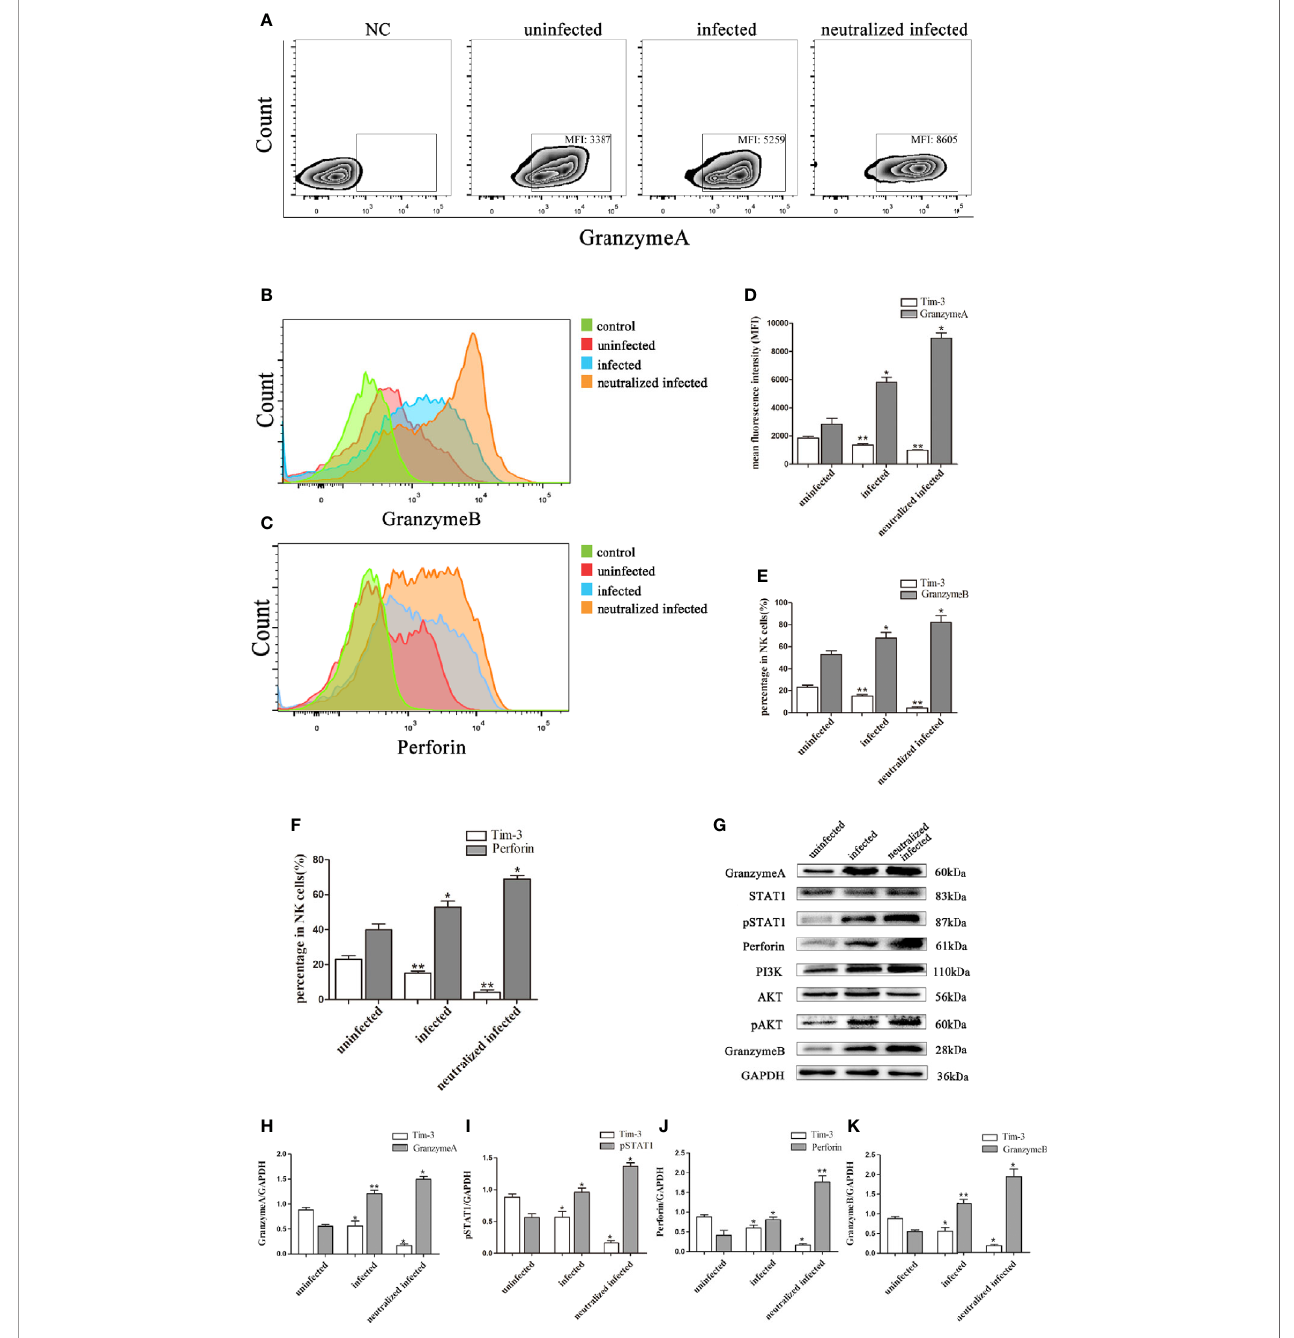
FIGURE 4 | Tim-3 down-regulation by T. gondii infection altered the GranzymeA, GranzymeB and Perforin expressions of human dNK cells. (A-F) Representative fl ow cytometry and histograms analysis of GranzymeA (A, D) , GranzymeB (B, E) and Perforin (C, F) levels of human dNK cells in the uninfected, infected, and neutralized infected groups. (Means ± SD; N=6 human samples per group, * p < 0.05, ** p < 0.01, by unpaired t -test). (G) Western blot analysis of signaling pathway of Perforin and GranzymeB. Since GranzymeB is also modulated by PI3K-AKT signaling pathway and the experiments were performed at the same time, the data of PI3K, AKT and pAKT in Figure 4G were reused from the data of Figure 2H . (H-K) Histograms analysis of GranzymeA, pSTAT1, Perforin and GranzymeB in uninfected, infected, and anti-Tim-3 neutralized infected groups. (Means ± SD; N=6 human samples per group, * p < 0.05, ** p < 0.01, by unpaired t